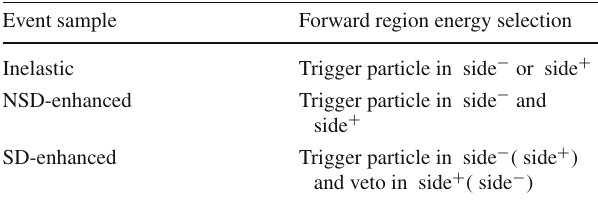
Table 1 Summary of stable-particle level definitions for each of the event samples, corresponding to the inelastic, the NSD-enhanced, and SD-enhanced categories. Charged particles are selected with p T > 0 . 5GeV and | η | < 2 . 4. Forward trigger particles correspond to those with energy E > 5GeV located in side − (defined as − 5 < η < − 3) and/or side + (defined as 3 < η < 5). Similarly, a veto corresponds to the absence of a trigger particle with E > 5GeV in side − and/or side